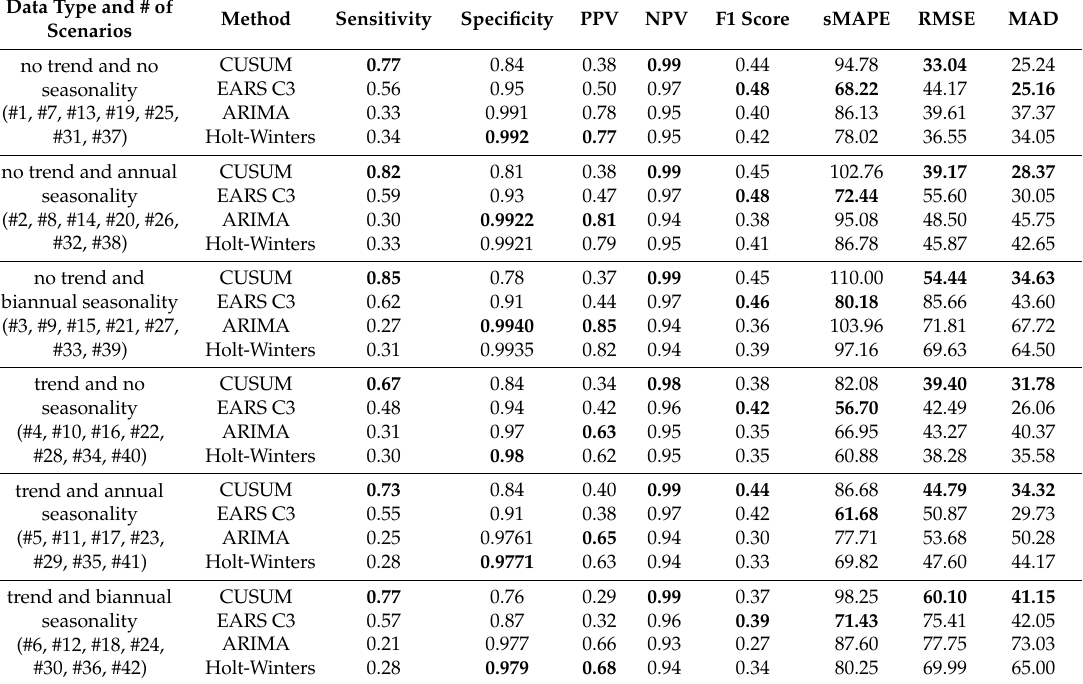
Table 1. The comparison of average performances for each type of time series.